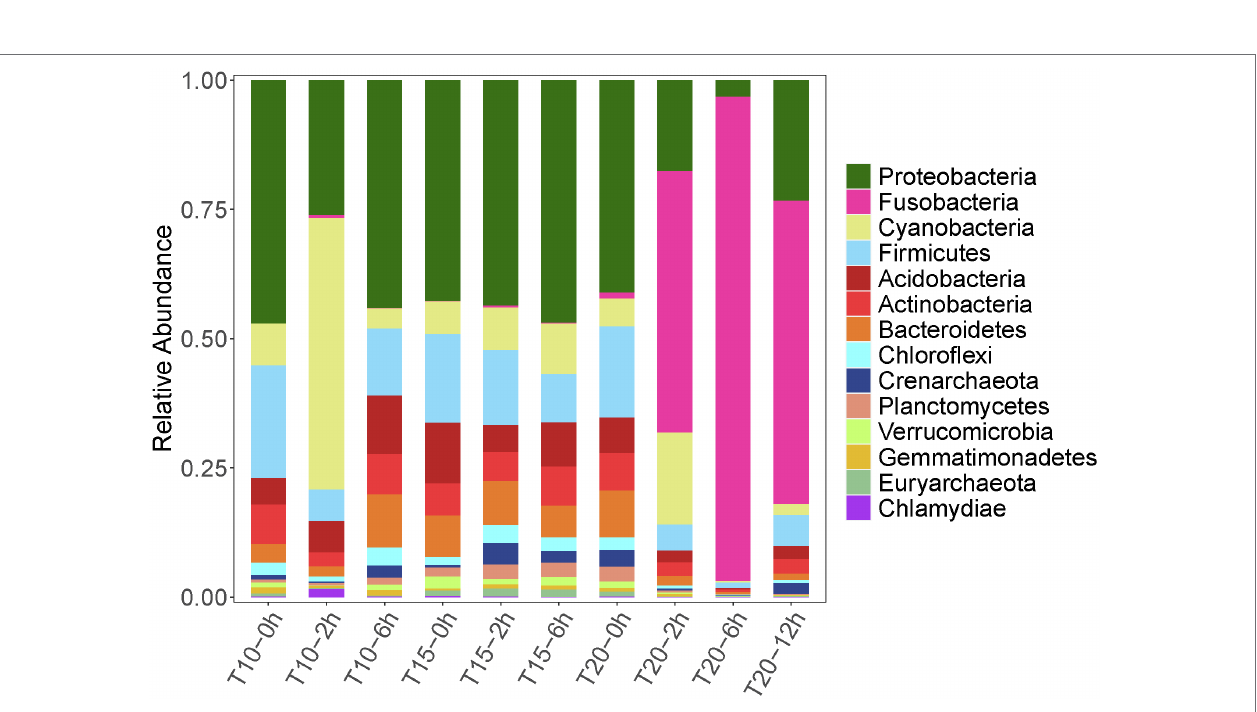
FIGURE 3 | Relative abundance dynamics of the dominant intestinal bacterial phyla for juvenile Oxygymnocypris stewarti during heat stress. T10, T15, and T20 indicate 10 ° C, 15 ° C, and 20 ° C acclimation temperature background of the experimental fish; 0, 2, 6, and 12 h represent duration of the heat stress.